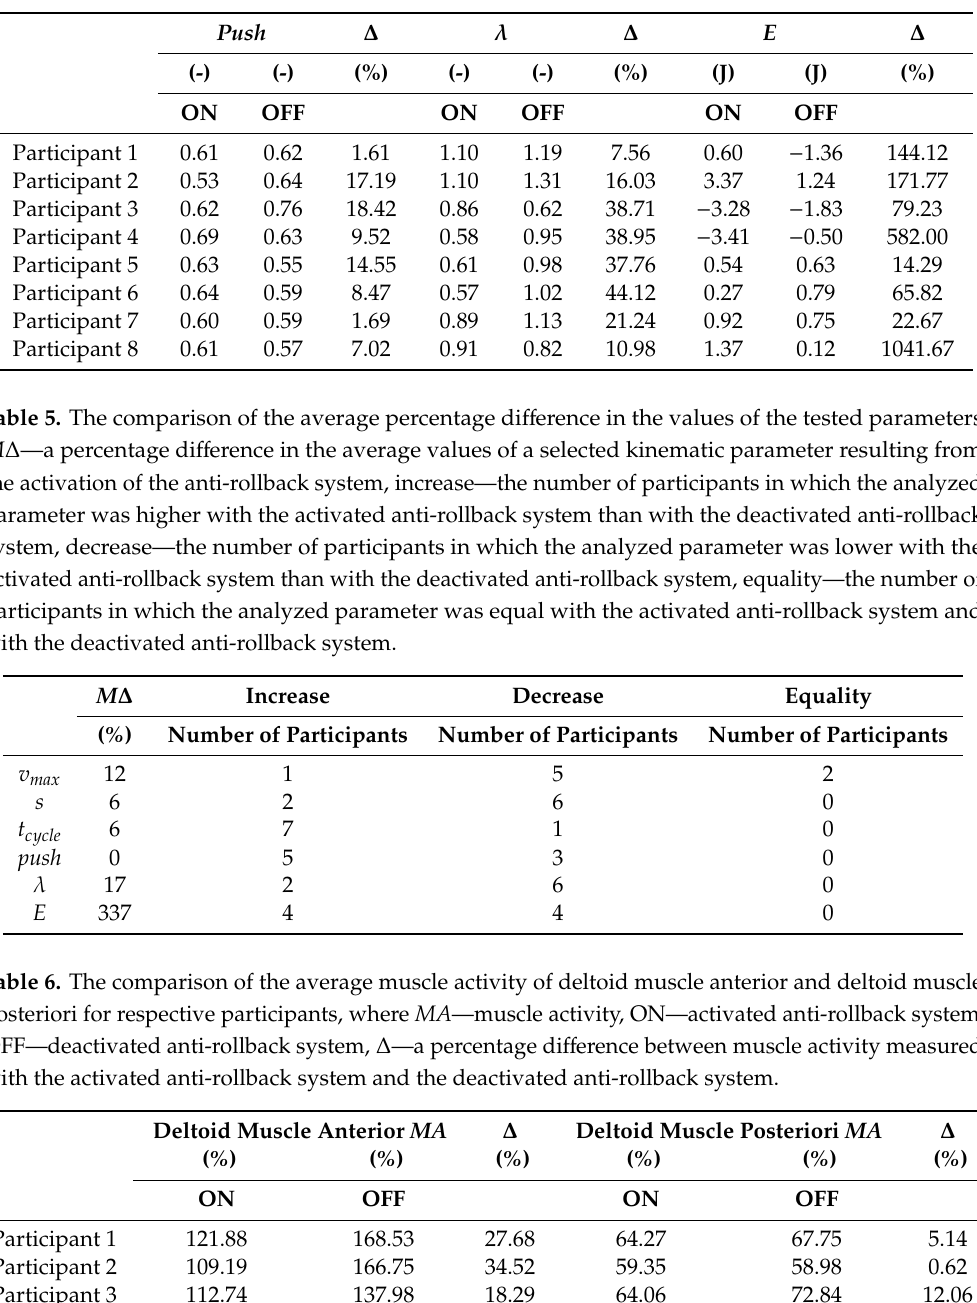
Table 4. The comparison of the average values of the push phase share in the entire propelling cycle, a coe ffi cient of the generated power and loss power ratio in the propelling cycle λ , total mechanical energy for a single propelling cycle E . Where: ∆ —a percentage di ff erence between the parameter measured with the deactivated anti-rollback-system and the activated anti-rollback system, ON—activated anti-rollback system, OFF—deactivated anti-rollback system.